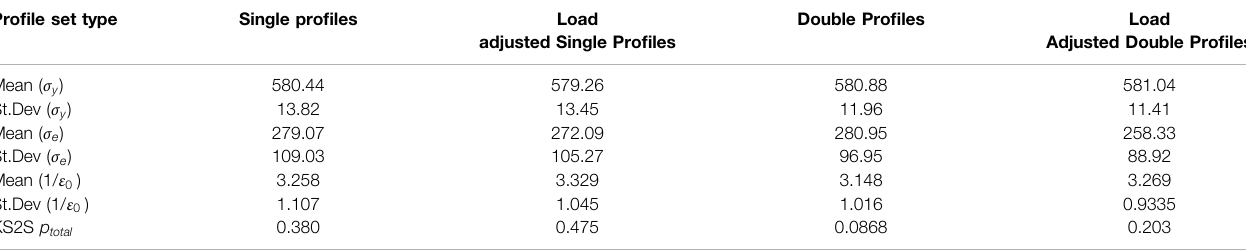
TABLE3| TheVoceparameterpredictionmeansandstandarddeviationsandthetotalprobabilitydeterminedbytheK-S2-Sampletest,foreachofthepro fi lesetsanalyzed inthiswork.Thesinglepro fi lesaretheX-pro fi les,theloadadjustedsinglepro fi lesareX-pro fi lesminusthelinearregressionmodelofload-variationeffectsonpro fi lometry. Thedoublepro fi lesaretheXpro fi lesaveragedwiththeYpro fi leswithrespecttoeachindentation,afteradjustingtheYpro fi lesforbias.Theloadadjusteddoublepro fi lesuse a different regression model, based on the double pro fi le set, to adjust pro fi les for the variations in loading between indentations. Pro fi le set